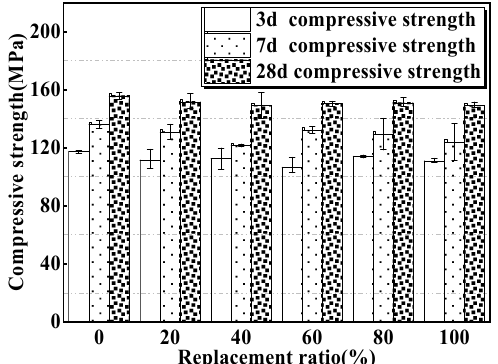
Figure 4. Compressive strengths of MUHPC with different magnetite contents.